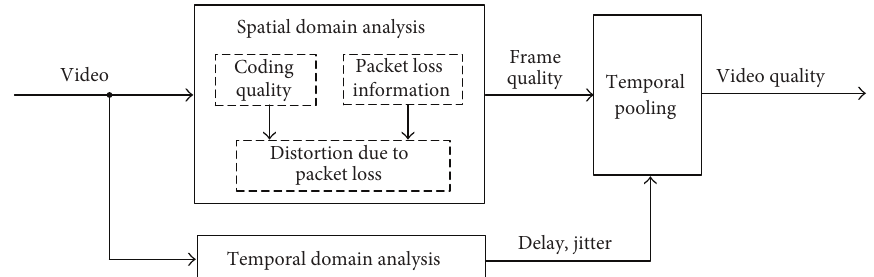
Figure 1: Framework of the video quality assessment with pooling mechanism.